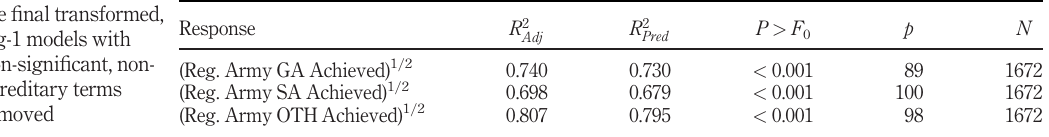
Table V. Summary of fi t for the fi nal transformed, lag-1 models with non-signi fi cant,